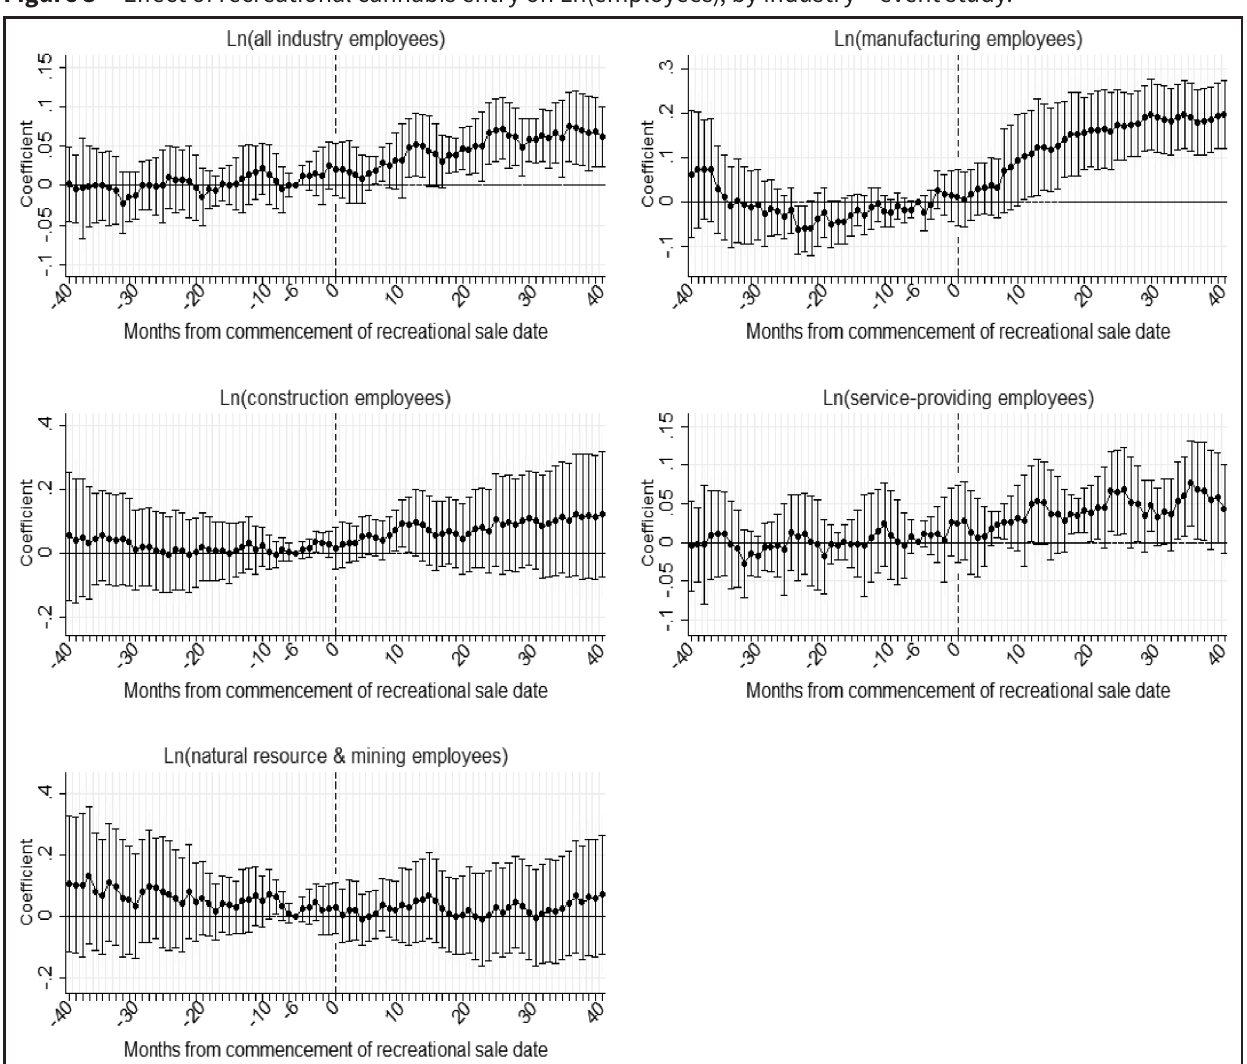
Figure 3 Effect of recreational cannabis entry on Ln(employees), by industry – event